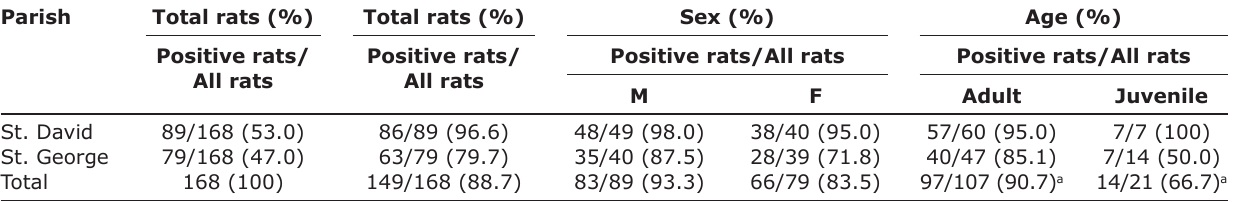
Table-2: Prevalence of ectoparasites on brown rats from Grenada (parish, sex, and age-wise).